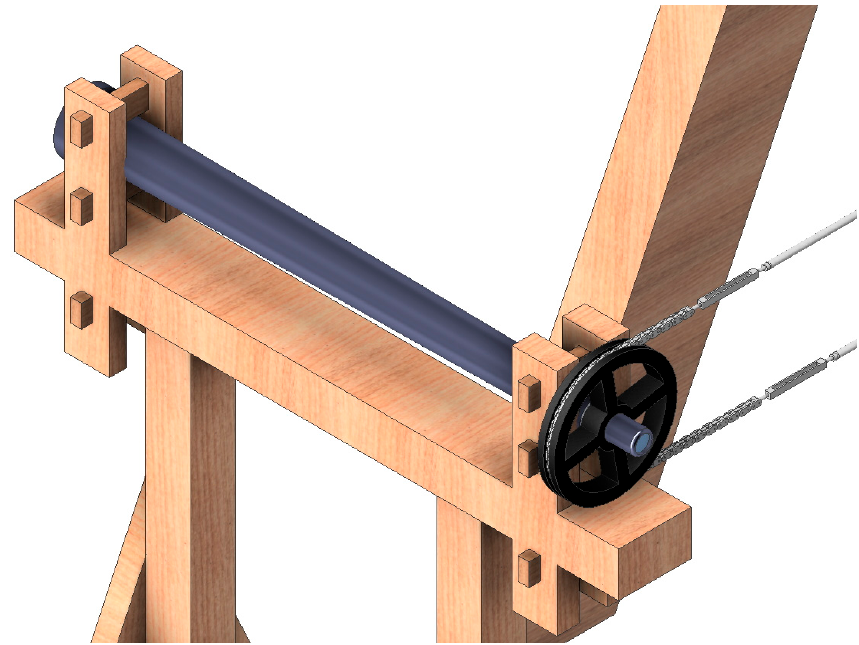
Figure 16. Detail of the placement of the telescope pulley on its frame.